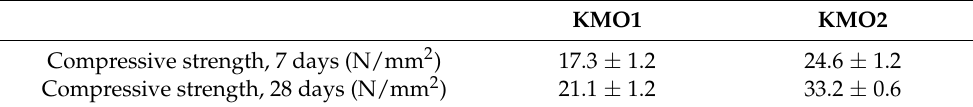
Table 7: Compressive strength of the KMO cements.